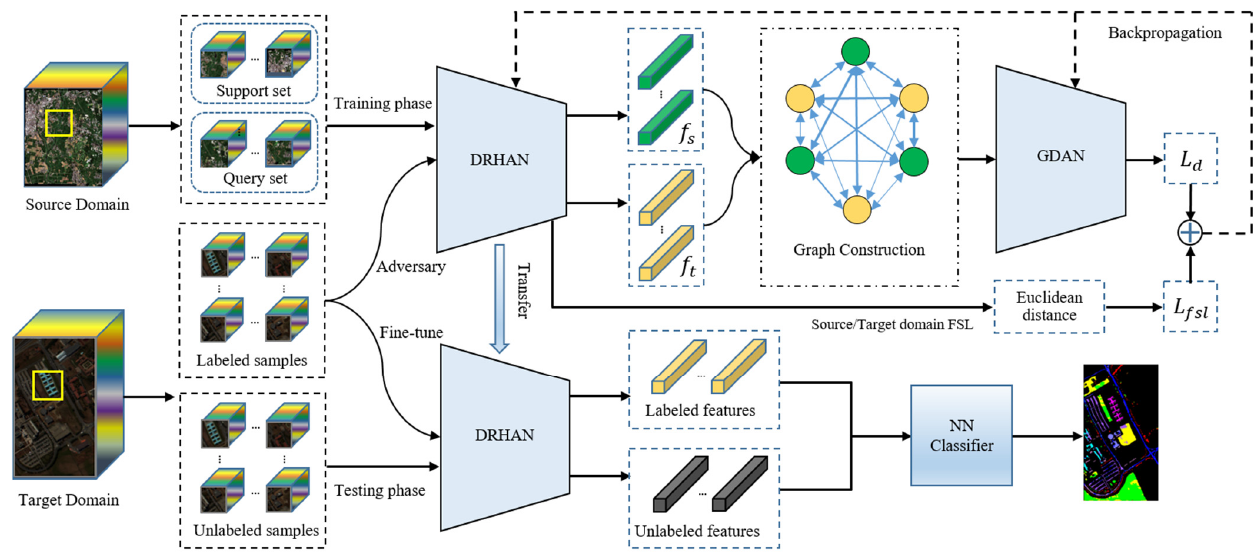
Figure 1. Framework of the proposed